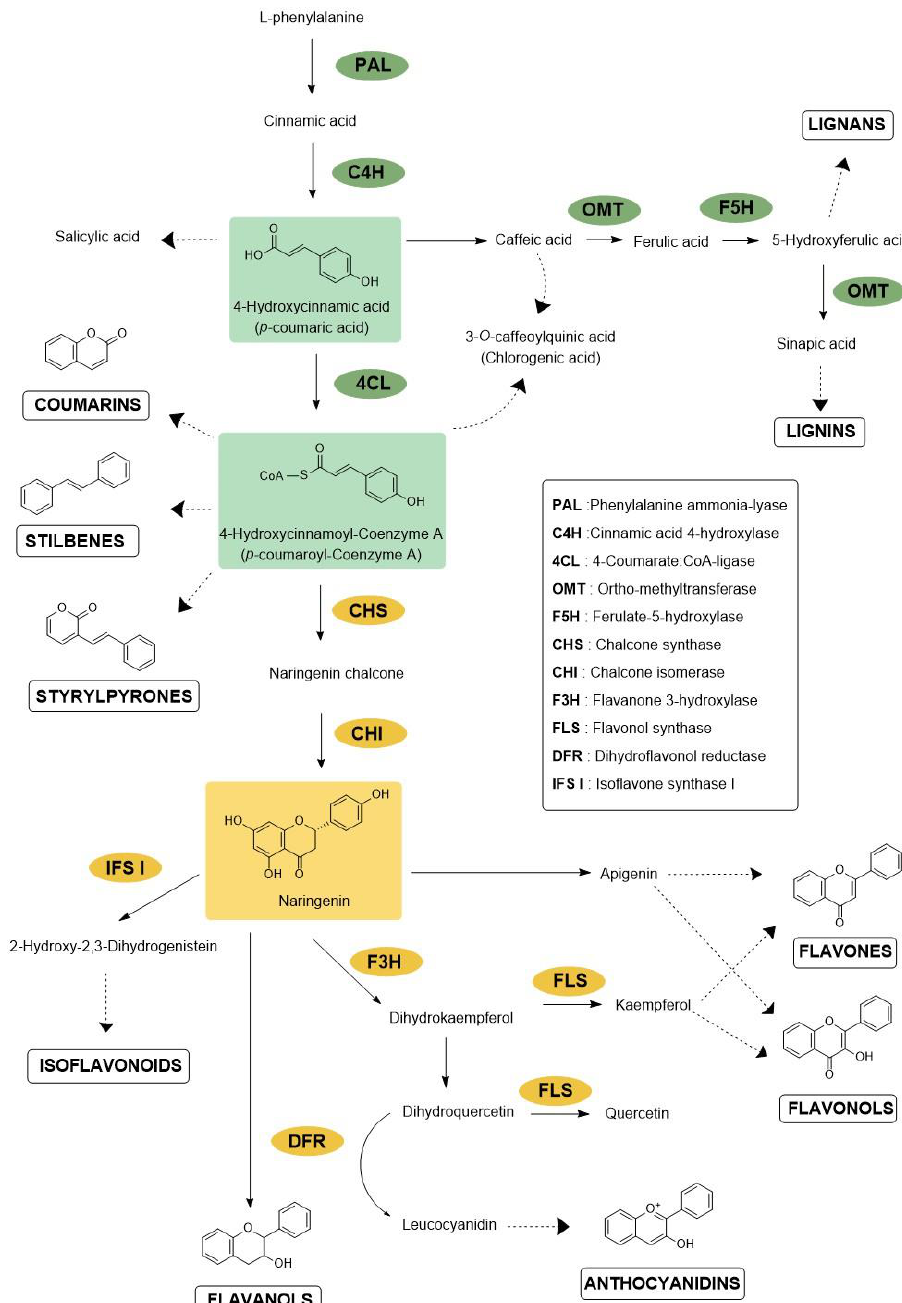
Figure 1. Main steps of the phenylpropanoid and flavonoid pathways. Enzymes mentioned in this paper are shown in green and yellow for central phenylpropanoid pathways and flavonoid biosynthesis, respectively. Complete arrows refer to one step in the biosynthetic pathway, whereas dashed arrows represent undetailed pathways leading to one molecule or molecule subfamilies.